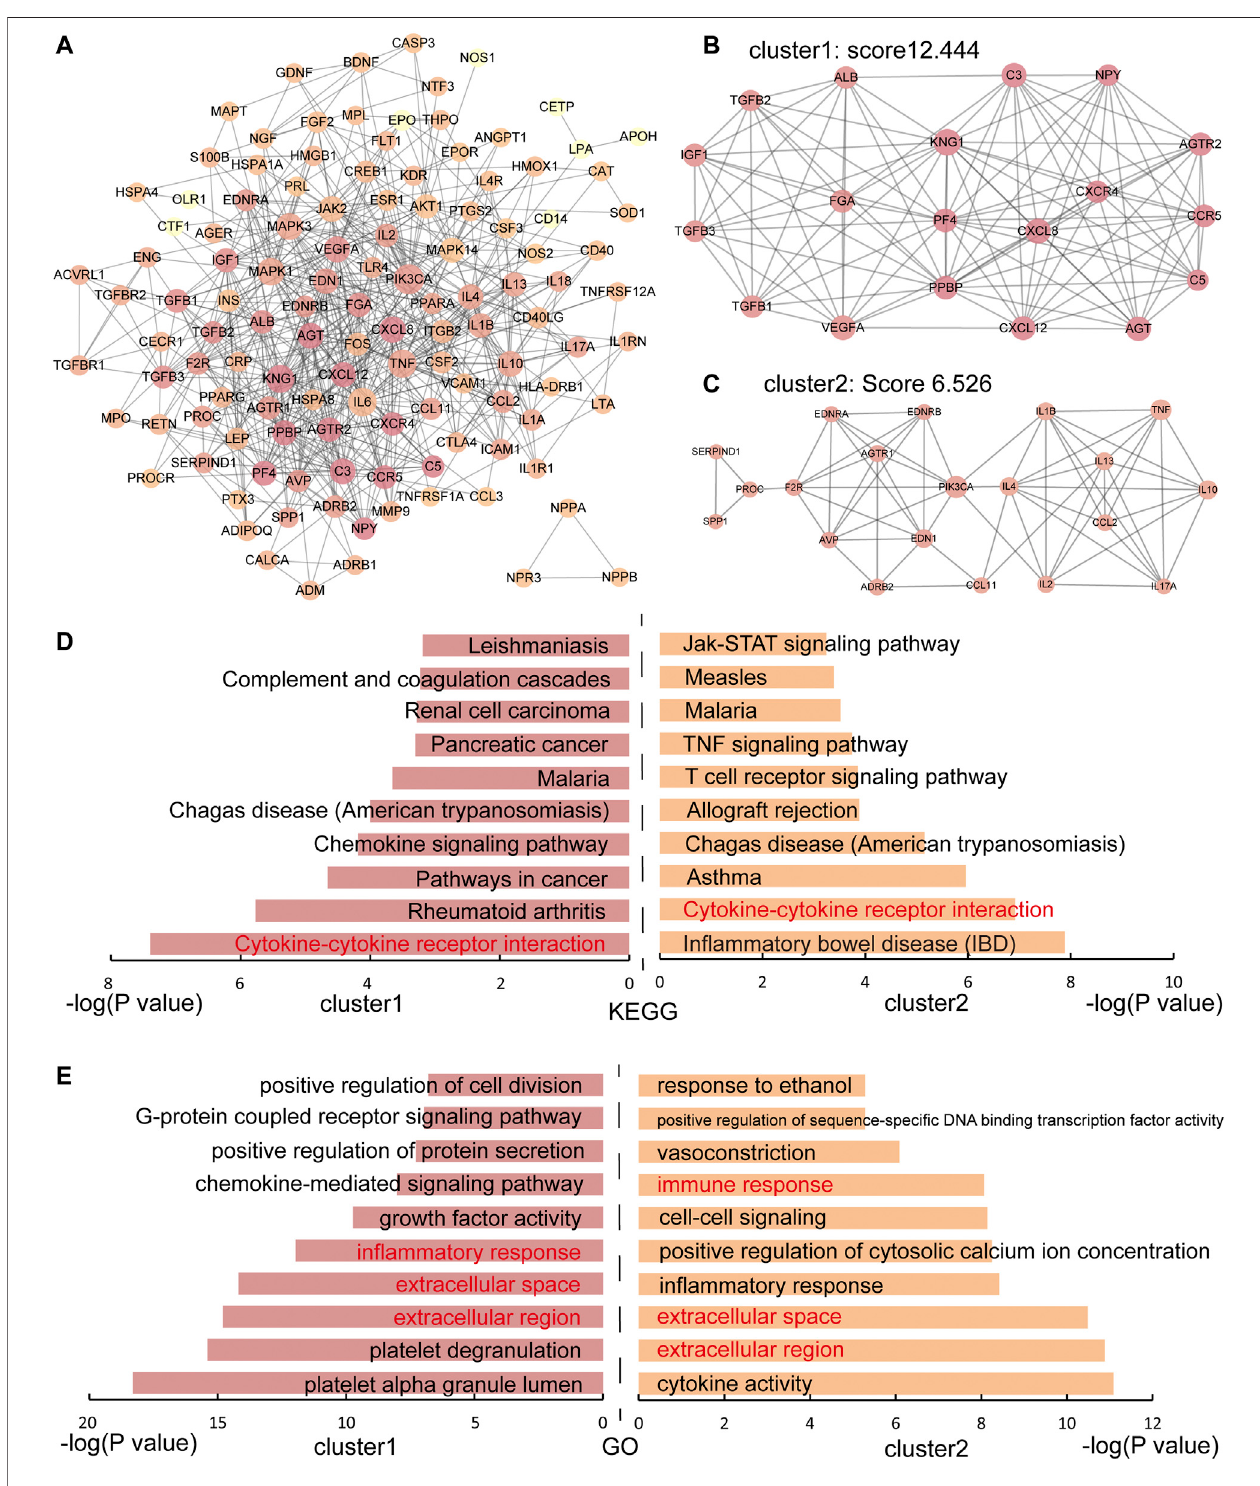
FIGURE1| ThePPInetworkandfunctionalenrichmentanalysisofISimmunegenes. (A) ThePPInetworkofISimmunegenes.Thedarkerthenode,thegreaterthe degree. (B-C) Two signi fi cant modules in the PPI network with MCODE scores ≥ 5. (D) KEGG enrichment analysis of immune genes in cluster 1 and cluster 2. (E) GO enrichment analysis of immune genes in cluster 1 and cluster 2. Shared pathways and processes between two clusters are shown in red.